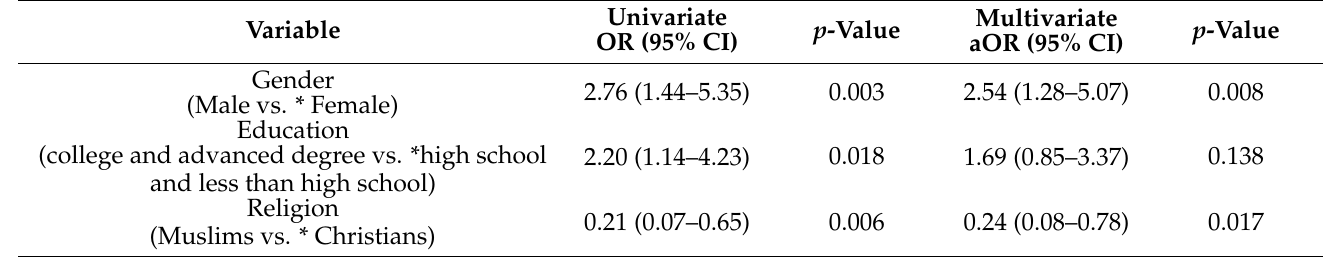
Table 5. Univariate and multivariate logistic regression using a model of active versus passive and shared decision-control preferences ( n =